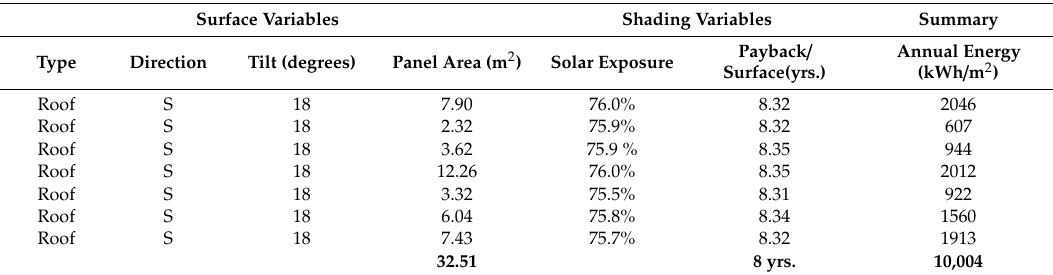
Table A1. Photovoltaic surface analysis and power generation results. Surface Variables Shading Variables